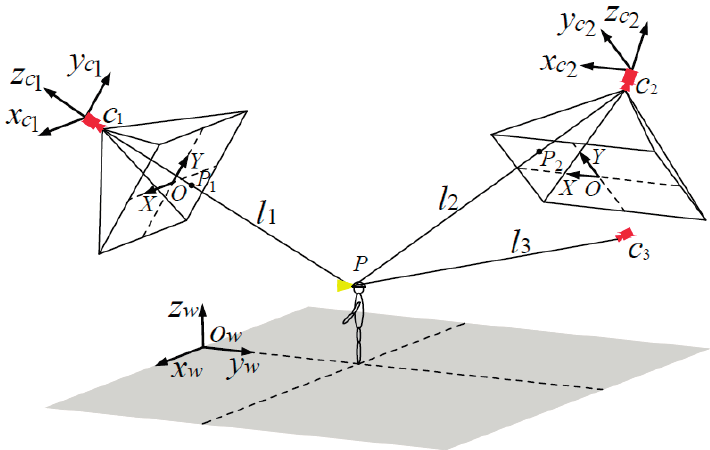
Figure 3. Camera vision imaging